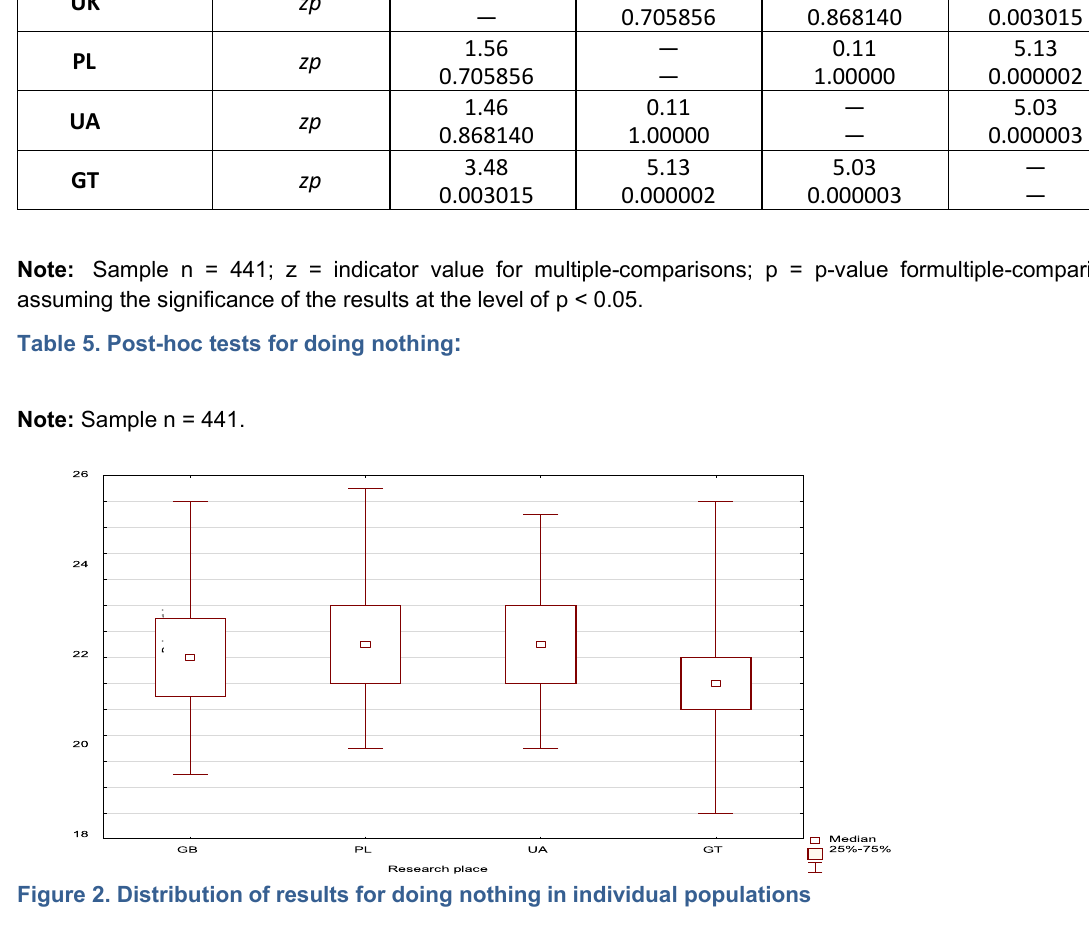
Figure 2. Distribution of results for doing nothing in individual populations